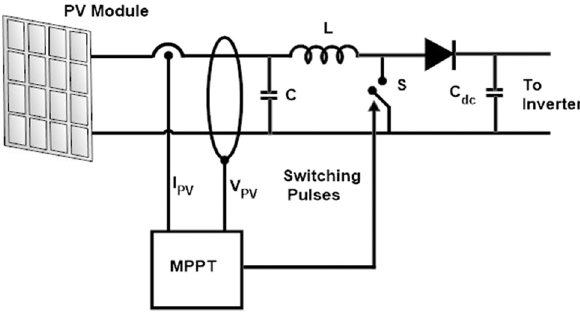
Figure 1: Solar system integrated with DC - EDC converter with max - imum power point tracking ( MPPT )